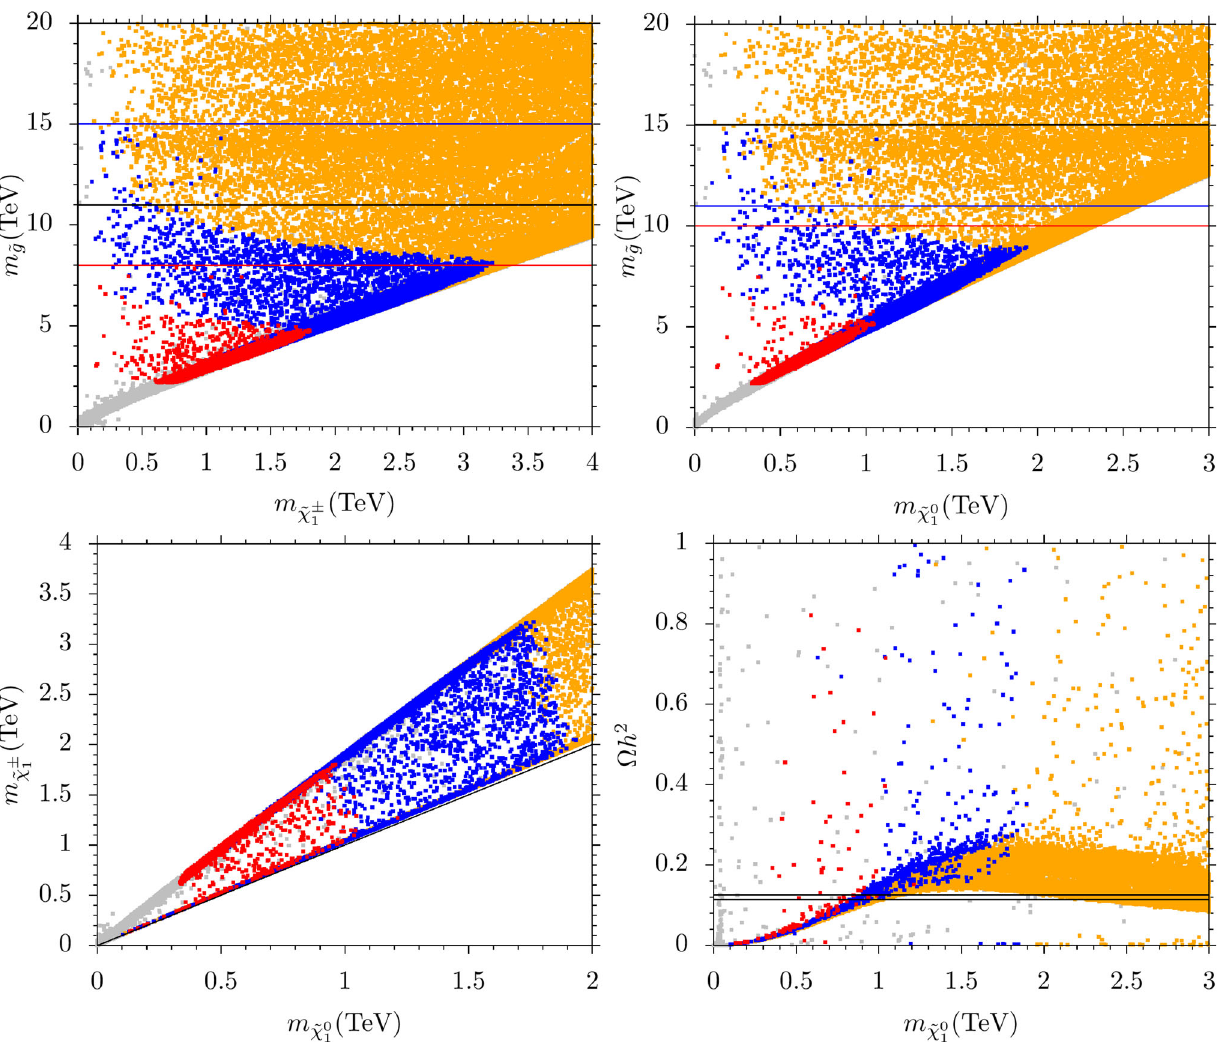
Fig. 4 The gluino mass versus the light chargino mass and lightest neutralino mass, the light chargino mass versus the lightest neutralino mass, and dark matter density versus the lightest neutralino mass. The color coding is the same as in Fig. 2 − m panel shows a graph in m ˜ χ ± ˜ g plane. It shows that for red 1 can be in the range from points the chargino mass m ˜ χ ± 1